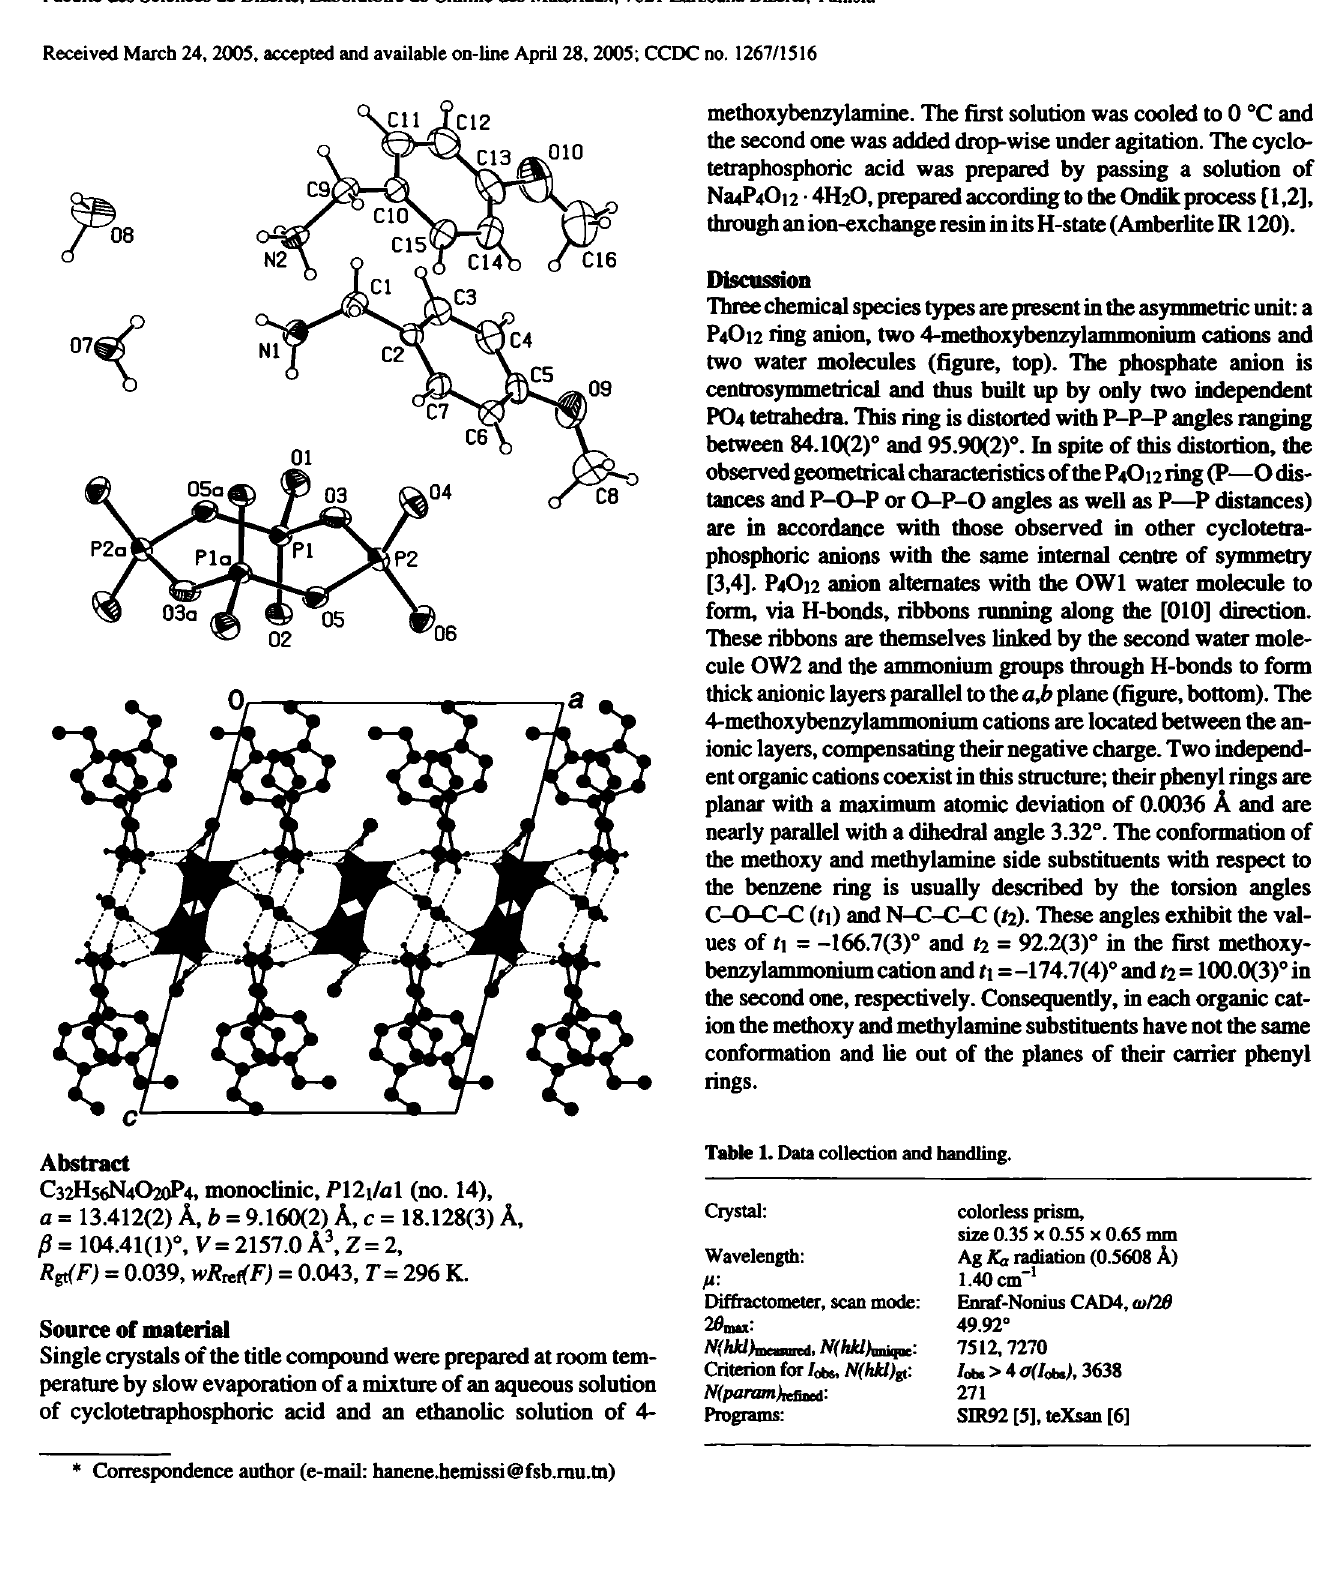
Table 1. Data collection and handling. Ciystal: